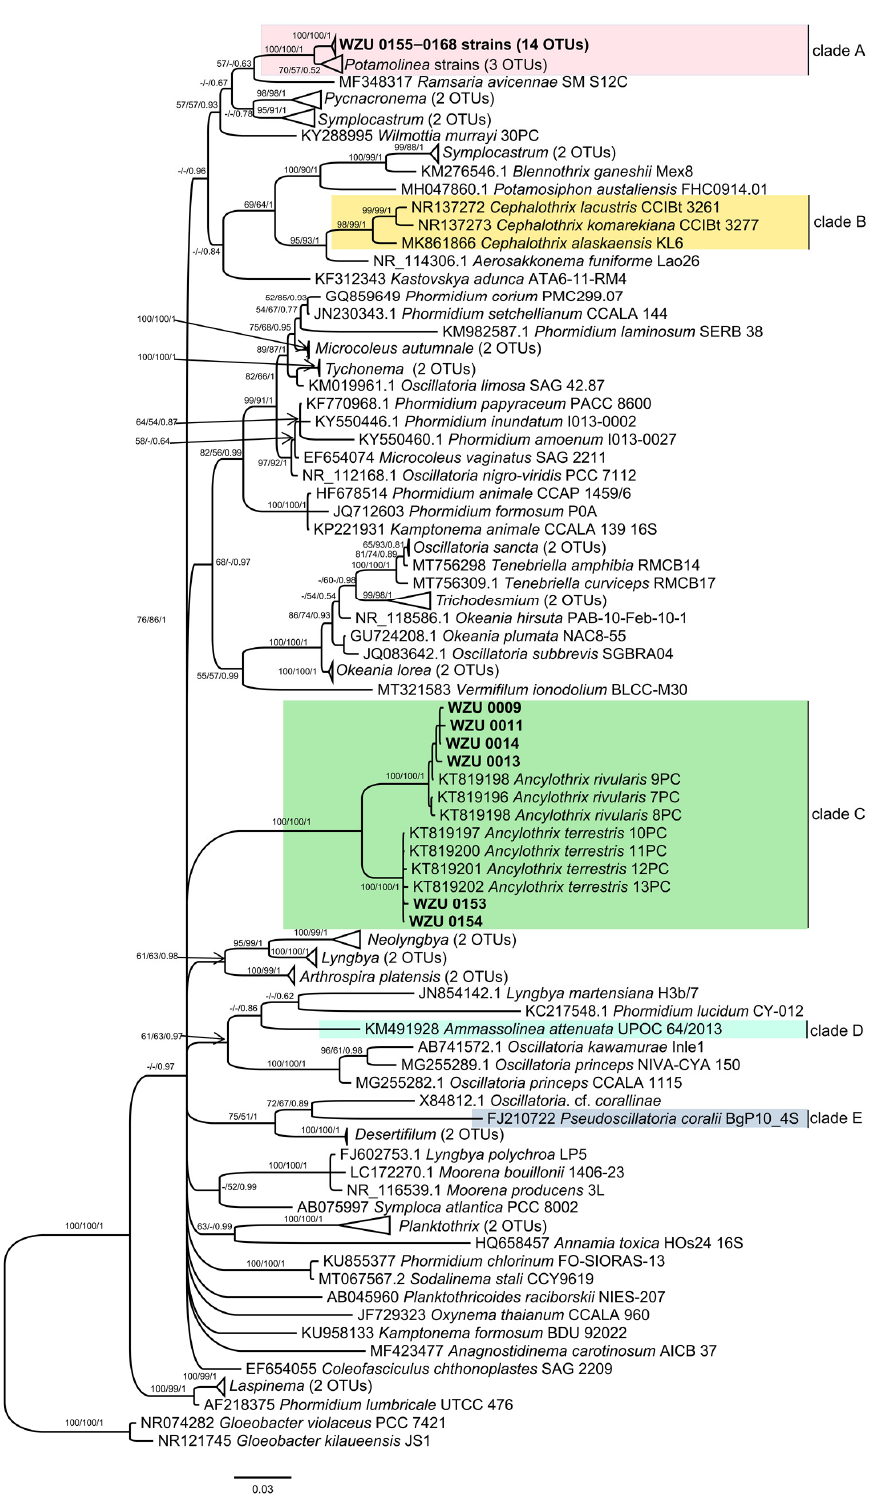
Figure 5. Bayesian inference (BI) phylogenetic tree of WZU strains based on 16S rRNA gene sequences. Bootstrap values greater than 50% are shown on the BI tree for NJ/ML methods and Bayesian posterior probabilities, clade A–E represent Potamolinea , Cephalothrix , Ancylothrix , Ammassolinea , Pseudoscillatoria . Bar, 0.03 substitutions per nucleotide position.